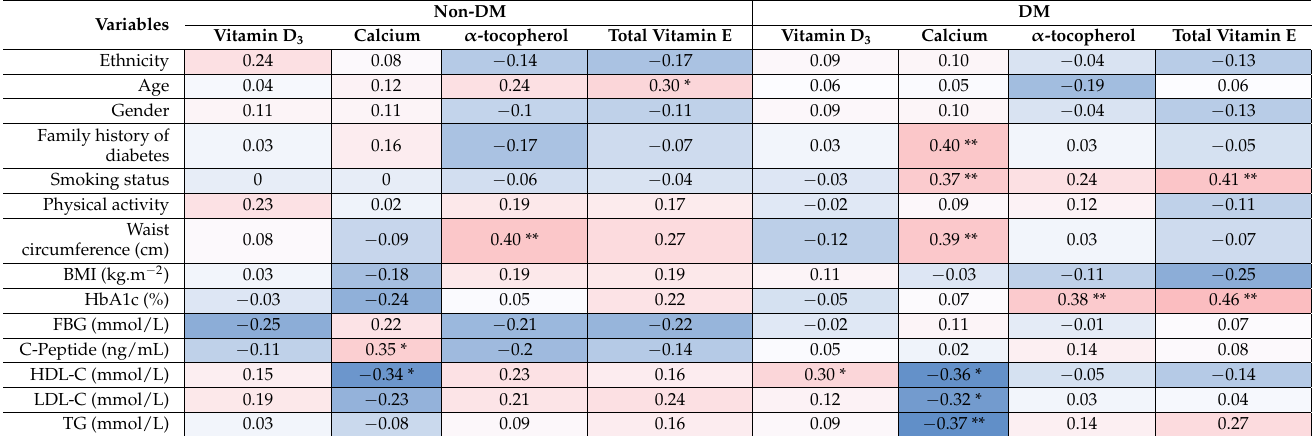
Table 11. Heat maps of the bivariate analysis for the correlation study determined using Spearman’s correlation coefficient.